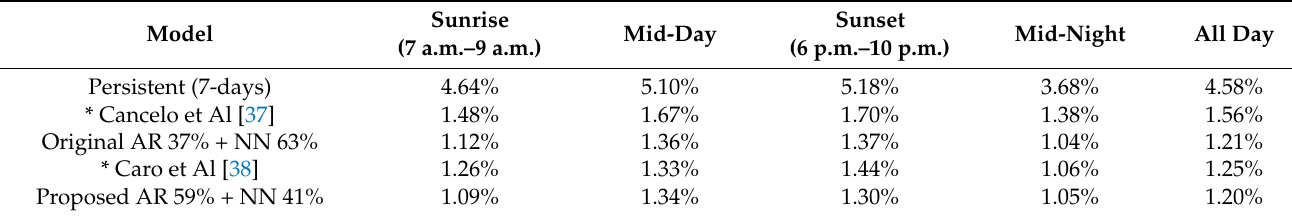
Table 7. Forecasting error of the benchmark and AR and NN models